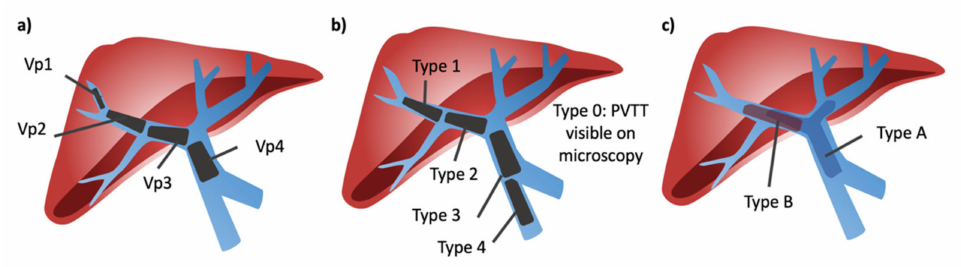
Figure 2. Portal vein tumor thrombosis classification systems. ( a ) Liver Cancer Study Group of Japan classification; Vp1 = thrombus located beyond second order branches, Vp2 = thrombus located in the second order branches, Vp3 = thrombus located in the first order branches, Vp4 = thrombus located in the main portal vein. ( b ) Cheng classification; Type 0 = PVTT seen only with microscopy, Type 1 = PVTT in the second-order segmental branches, Type 2 = PVTT in the right or left portal vein, Type 3 = PVTT in the main portal vein, and Type 4 = PVTT in the superior mesenteric vein. ( c ) Xu classification; type A = thrombus in main portal vein or both right and left portal veins, type B = thrombus in either right or left portal